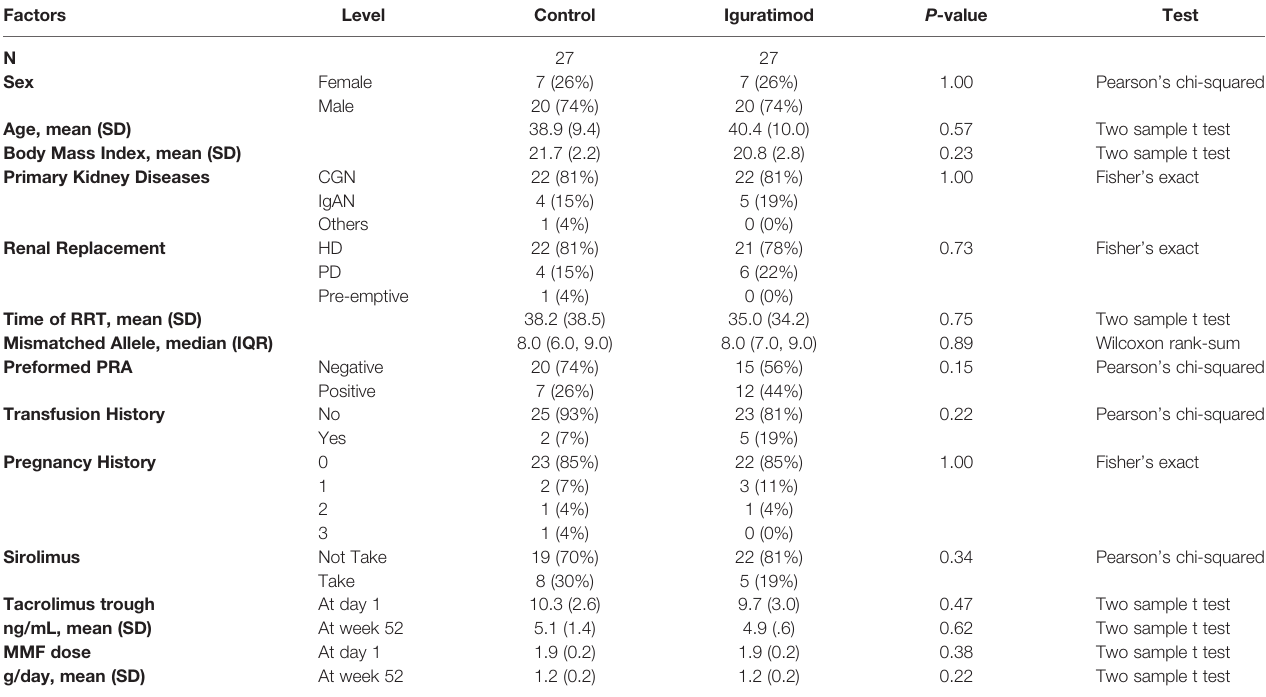
TABLE 1 | Demographic characteristics of mITT population. Factors